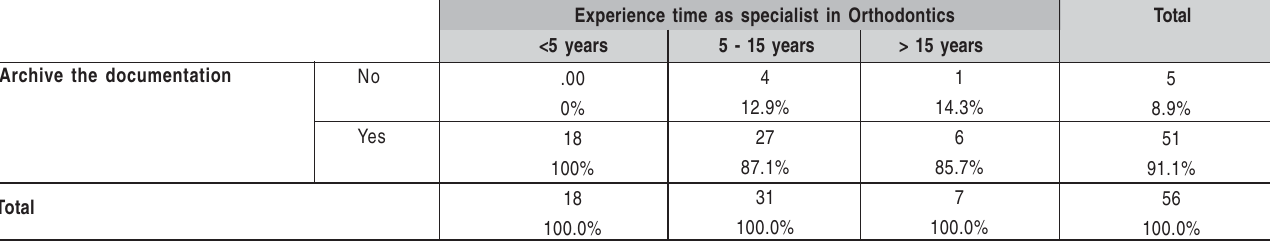
Table 4. Frequency distribution of Orthodontists that usually archive the documentation, stratified by the experience time as a specialist.